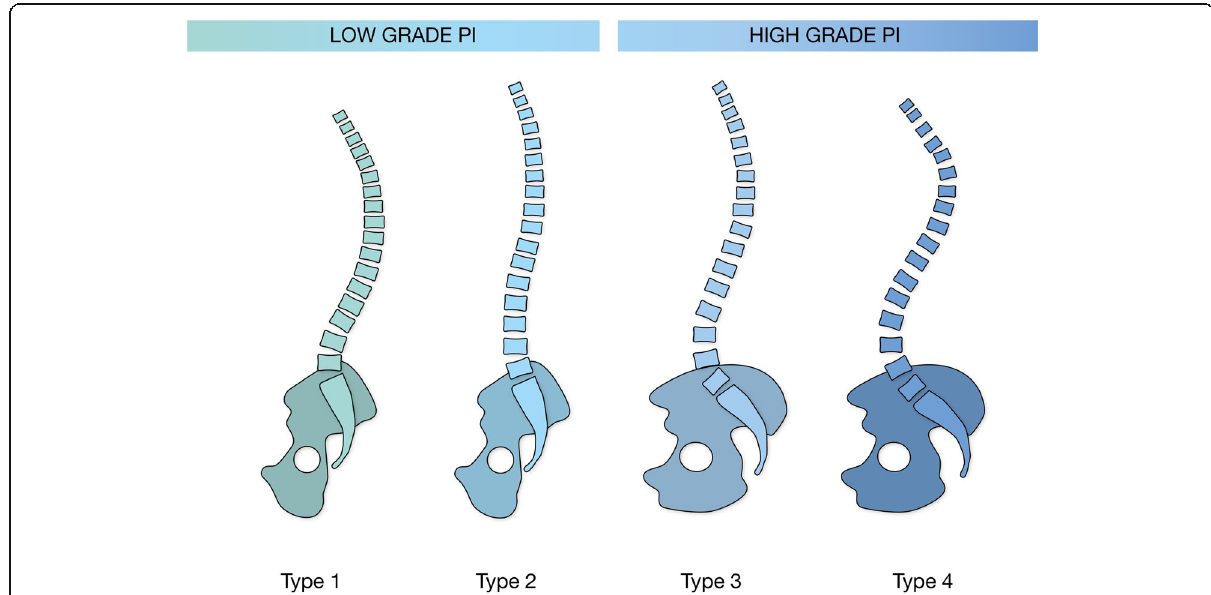
Fig. 1 The four Roussouly subtypes of sagittal